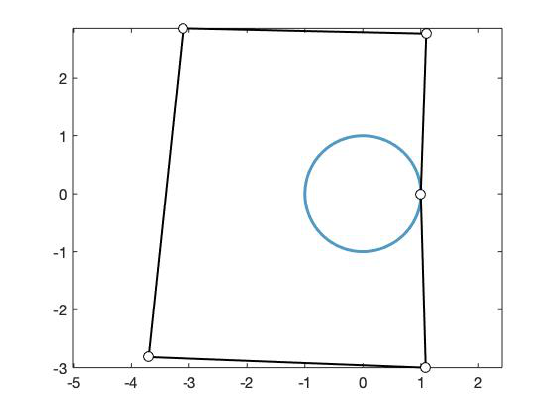
Figure 7. Fitting curve of degree 5 using f ( t ) = sin (( ∆ + t ) /2 ) and g ( t ) = sin (( ∆ − t ) /2 ) , t ∈ [ − ∆ , ∆ ] , and its control